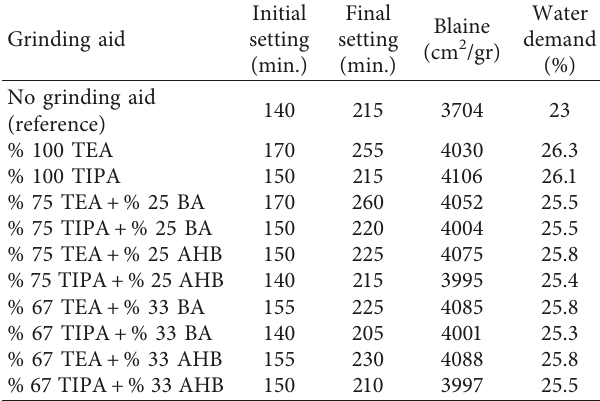
Table 1: Blaine, water demand, and the initial and final setting analysis results of the reference cement and ground cement with grinding aids and boron compound